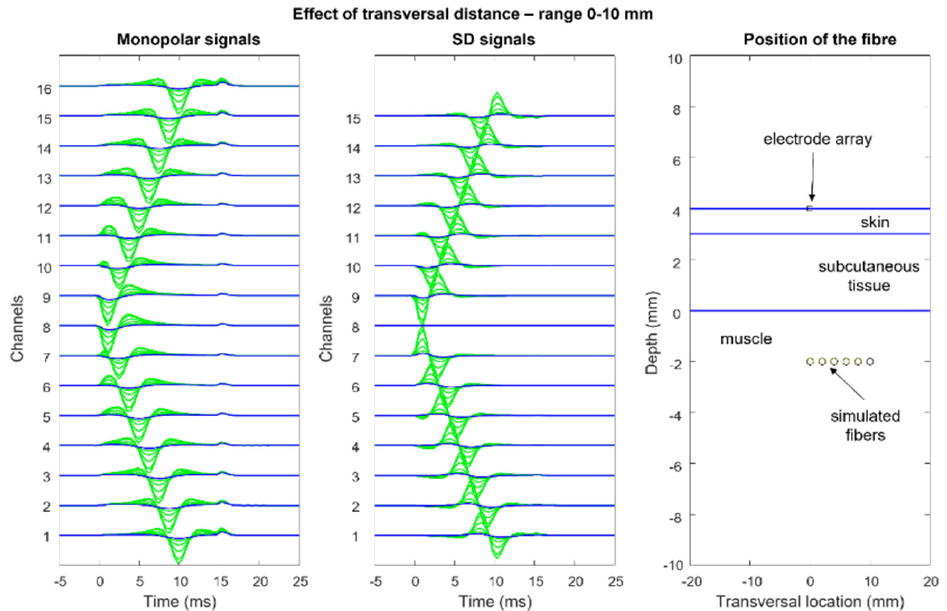
Figure 13. Effects of lateral displacement (transversal distance) between the electrode array and the fiber: same conditions as in Figure 12. Observe that the end-of-fiber effect is visible for distances of greater than 10–15 mm, where it becomes larger than the propagating component. This contributes to crosstalk between muscles that is still detectable at lateral distances of 20–30 mm from the edge of a muscle, mostly as a non-propagating component. (See animation in Supplementary Materials, Sup7). Reproduced from https://www.robertomerletti.it/en/emg/material/teaching/module9.